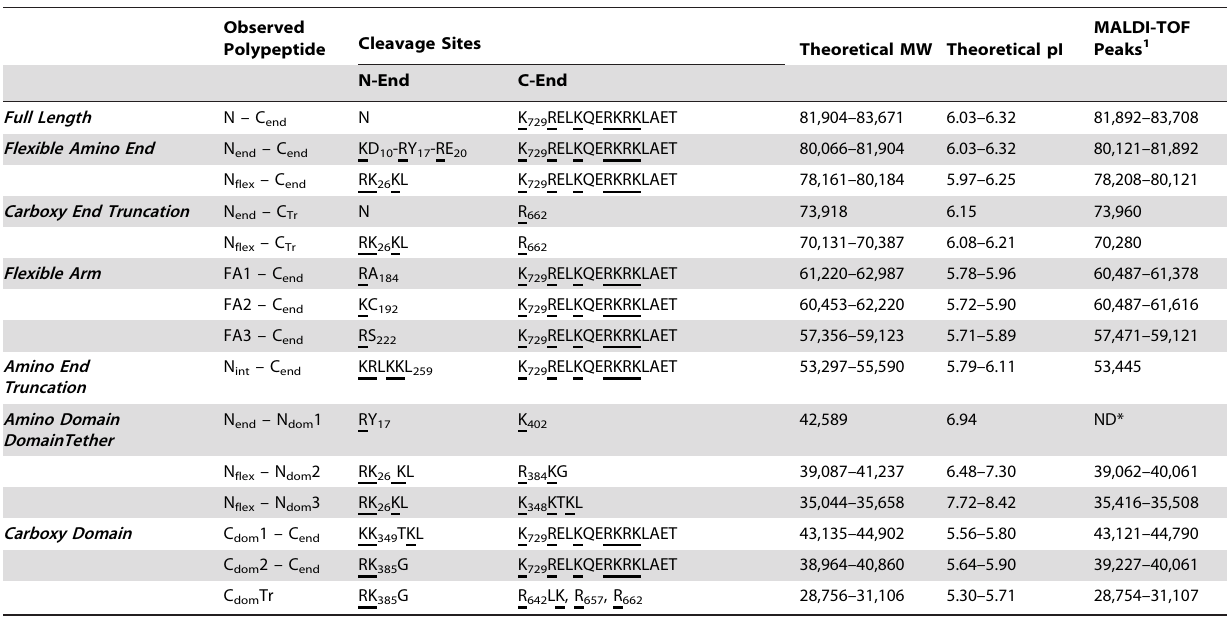
Table 2. D. melanogaster tRNase Z – Trypsin